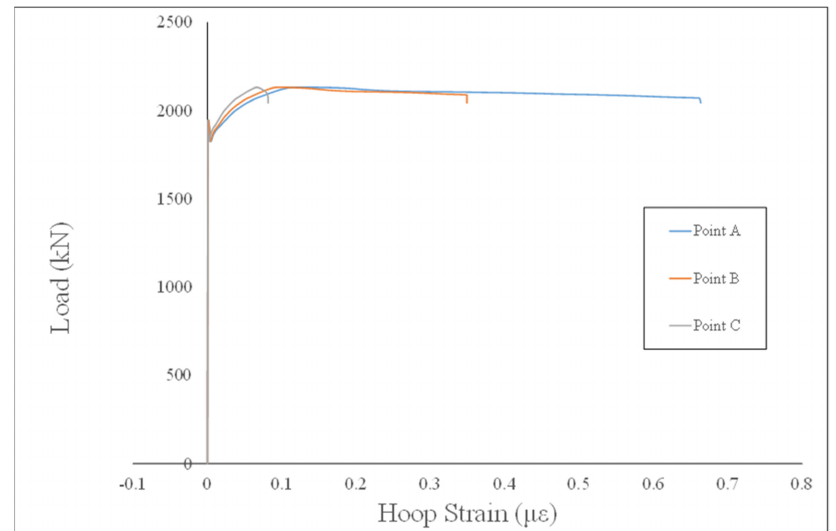
Figure 15. Hoop strain of different points on specimen